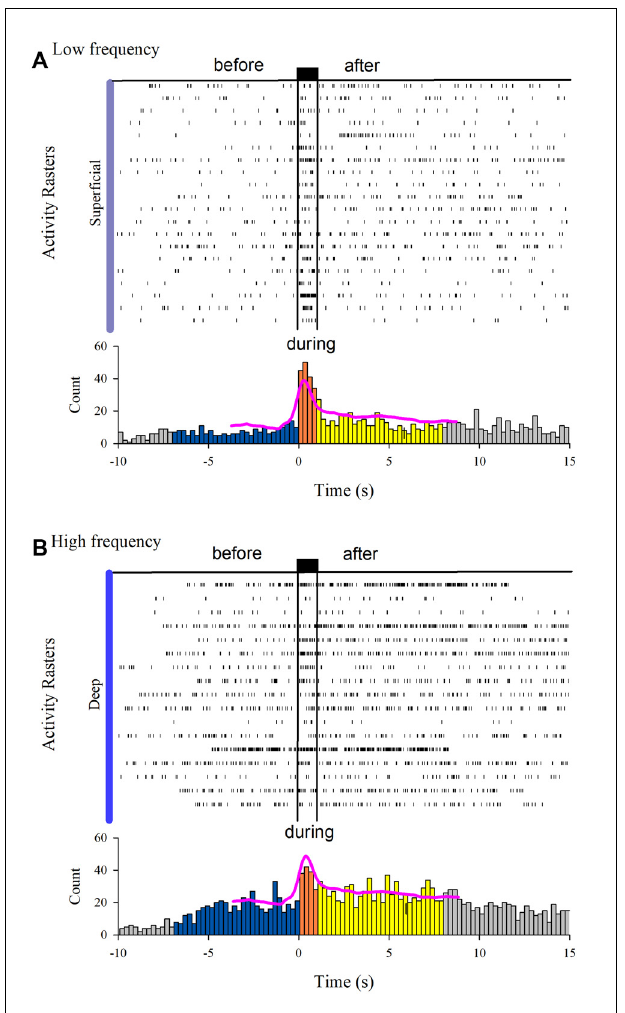
FIGURE 5 | Firing rate distribution for the superficial and the deep dorsal horn neurons. (A) The depth vs. the firing rate (frequency in Hz) of superficial and the deep dorsal horn neurons before and after the vibratory stimuli. (B) Mean firing rate of the superficial and deep dorsal horn neurons for both conditions before and after the vibratory stimuli. (C) The after/before ratio of firing rate for the superficial and the deep dorsal horn neurons vs. the depth in which they were